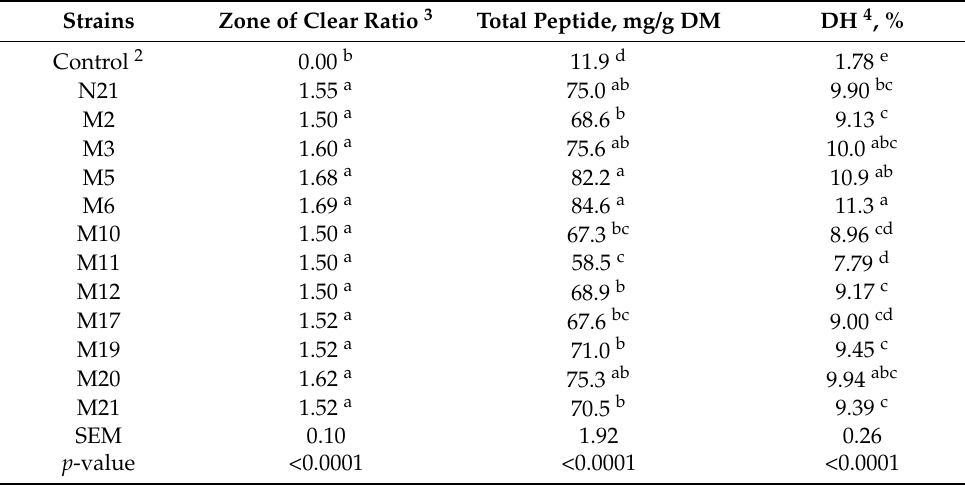
Table 2. Effect of different screening strains on the clear zone/colony diameter ratio in MBM agar plate or total peptides and DH in FMSMPs 1 .